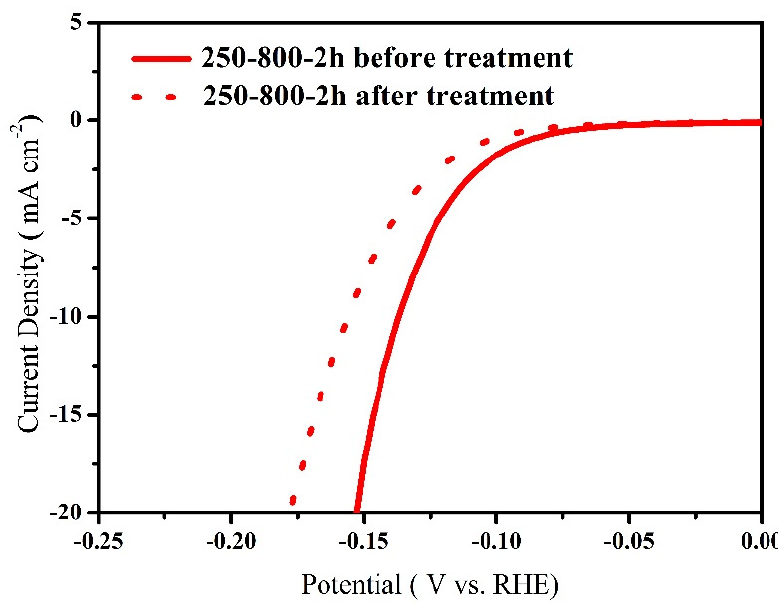
Figure 8. Polarization curves of the 250-800-2h catalyst before and after acid treatment in 0.5 M H 2 SO 4 solution.